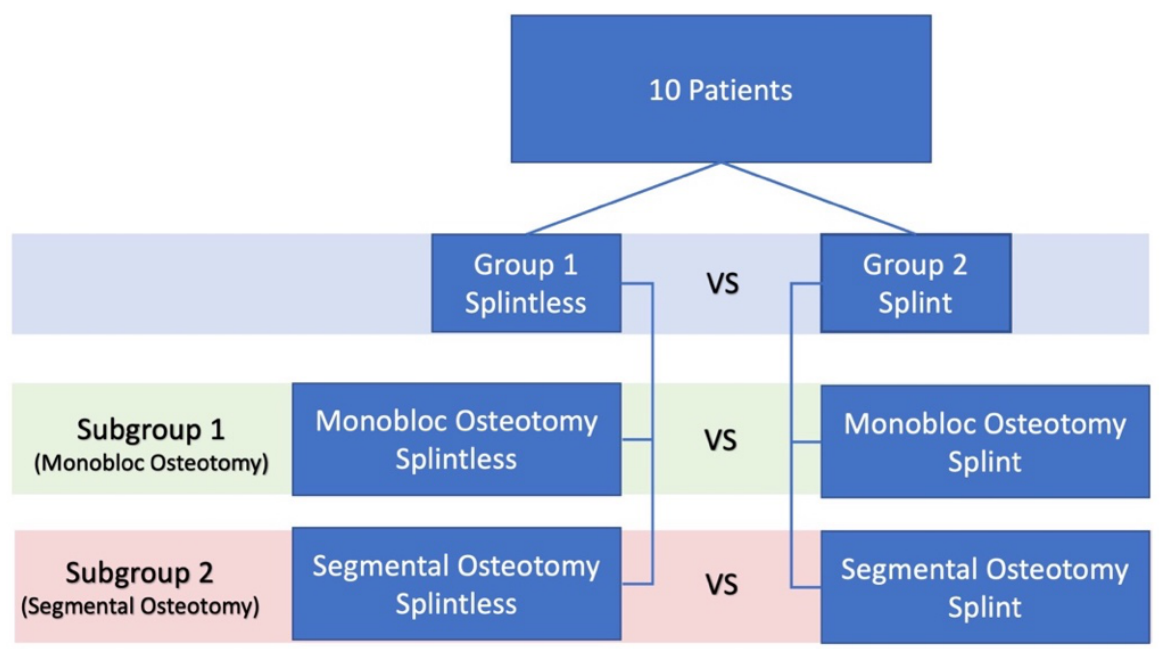
Figure 1. Sample Figure 1. Sample subdivision.